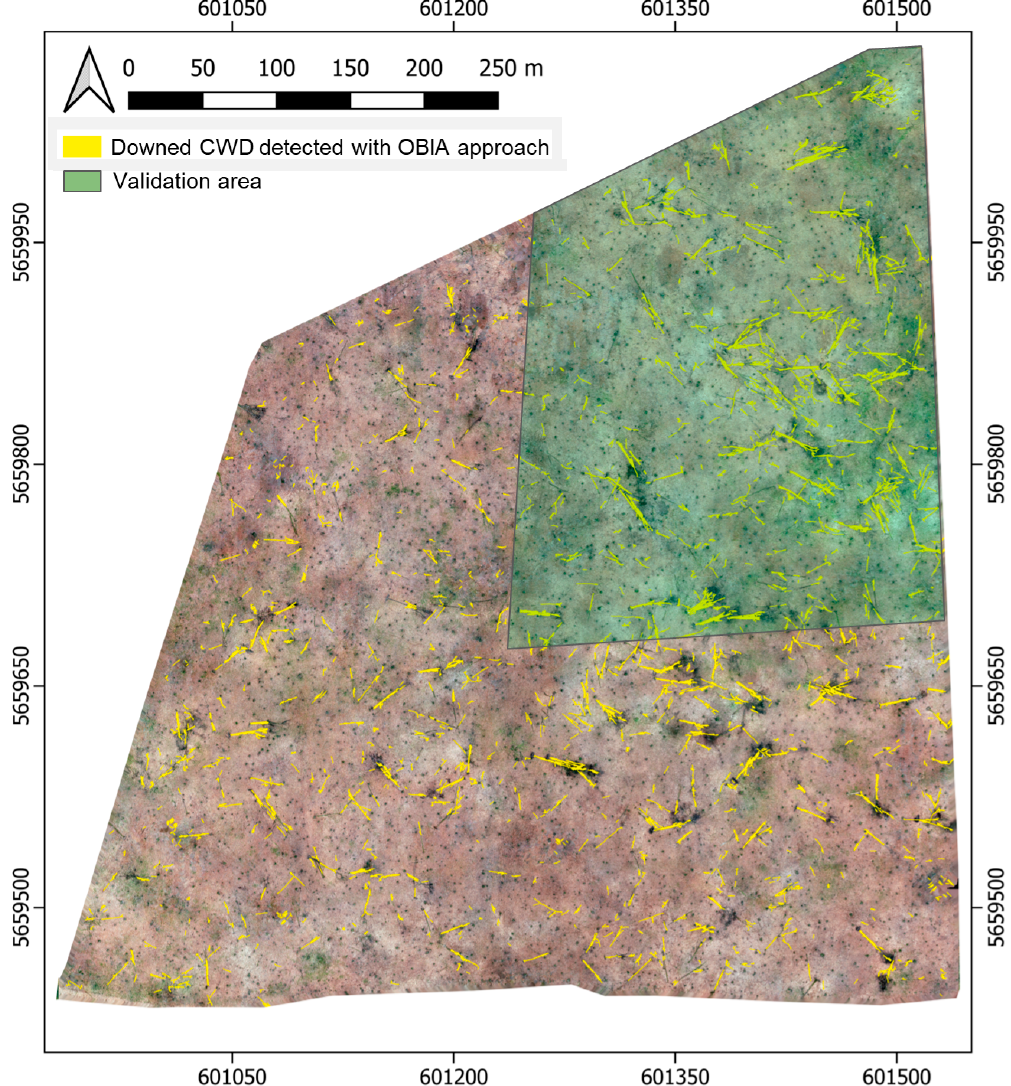
Figure 8. CWD map of the entire Huss site including validation area. An initial visual assessment suggests that the developed object-based image analysis (OBIA) approach is able to identify the predominant part of the CWD. predominant part of the